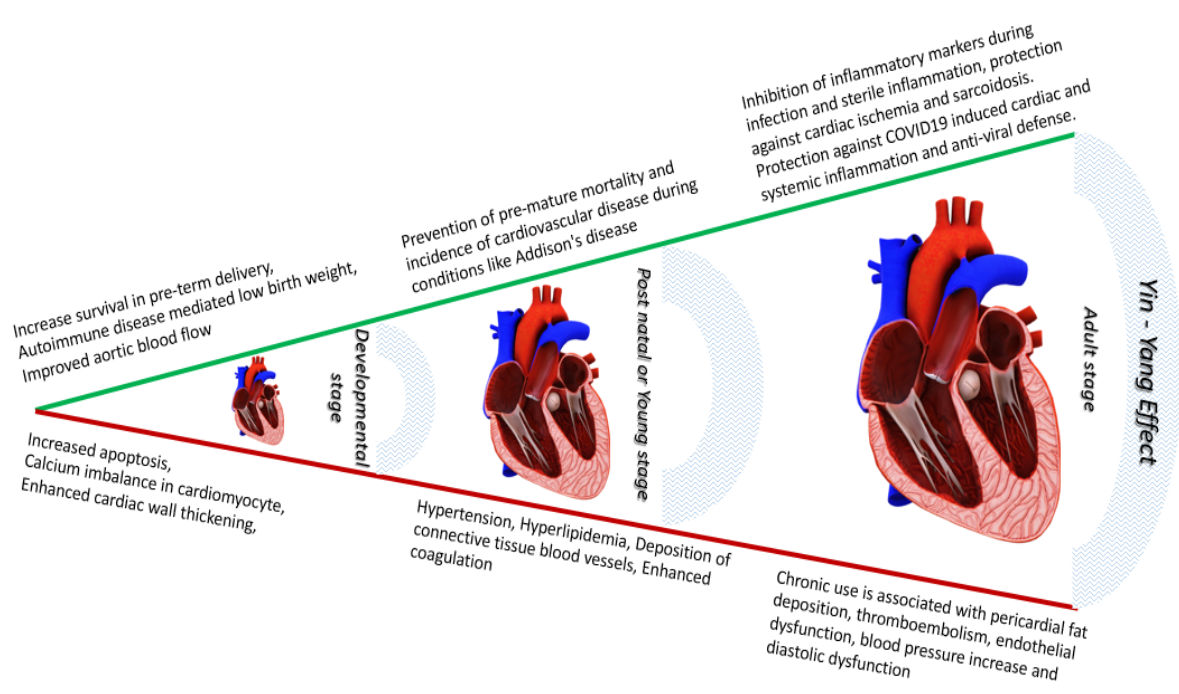
Figure 1. The Yin-Yang effect of glucocorticoids on cardiovascular system — glucocorticoids whether endogenous or exogenous have an inevitable role from developmental stage to post-natal and adult stages. GCs provide crucial protection to cardiovascular system against autoimmune attack on cardiovascular system during all the human life stages combined. The role of GCs against COVID-19 mediated attack on cardiovascular system is a newly identified role. In contrast, excess GC level could lead to cardiac cell apoptosis, cardiac wall thickening, along with hypertension, hyperlipidemia and endothelial dysfunction when exposed to GCs chronically debilitating cardiovascular function.